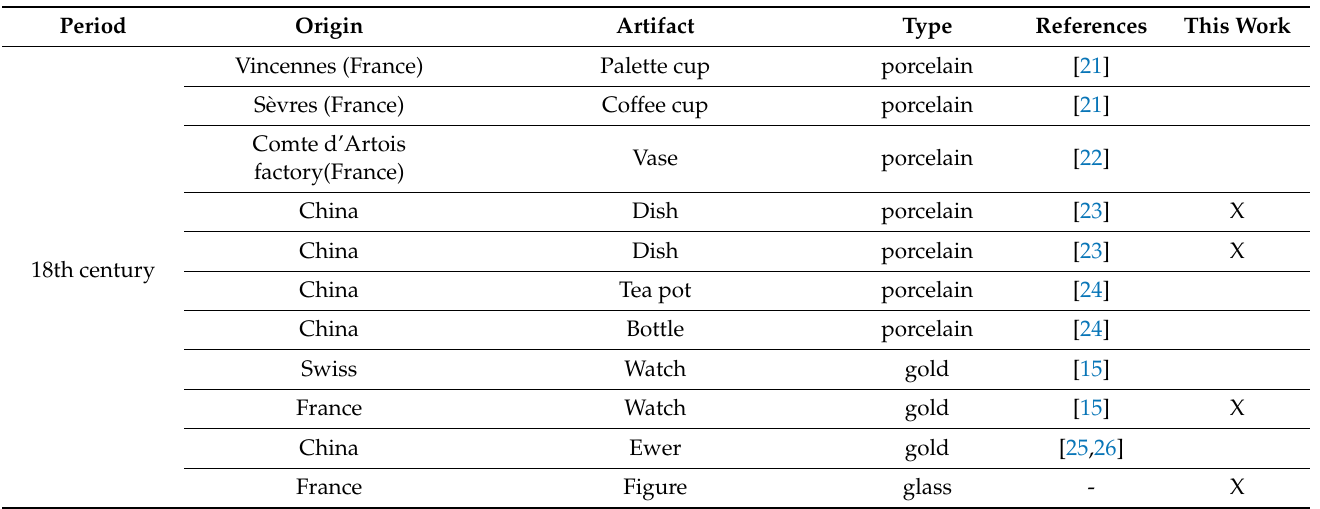
Table 1. Representative artifacts currently and previously